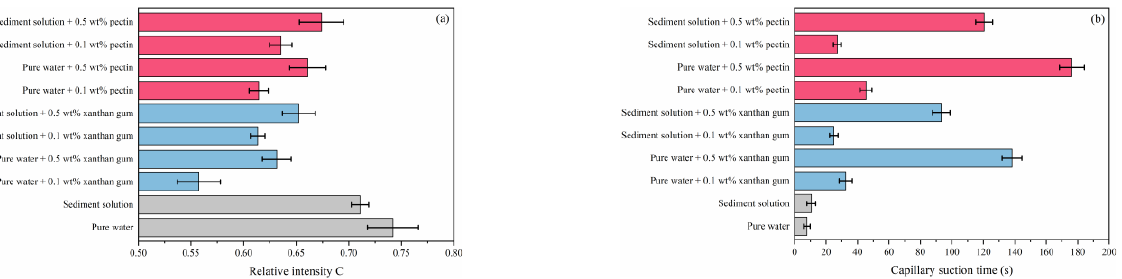
Figure 7. Disturbance and binding effects of natural gels on water molecules: ( a ) The relative intensity C representing the disturbance on water molecules; ( b ) Capillary suction time.